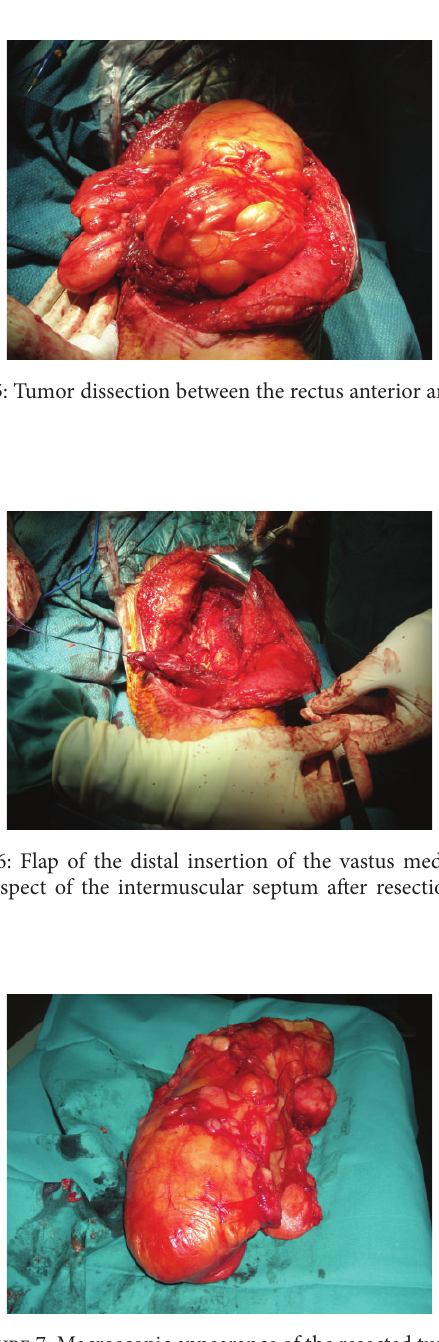
Figure 7: Macroscopic appearance of the resected